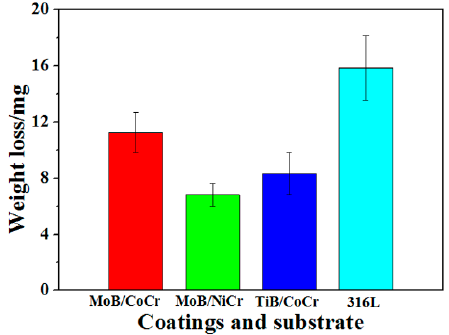
Figure 18. Abrasive weight loss of the boride-based coatings and 316L stainless steel substrate.